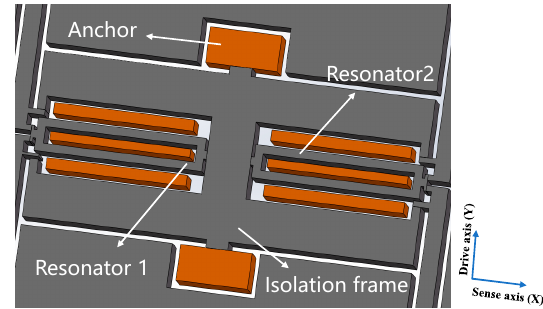
Figure 5. Stress relief anchor design.